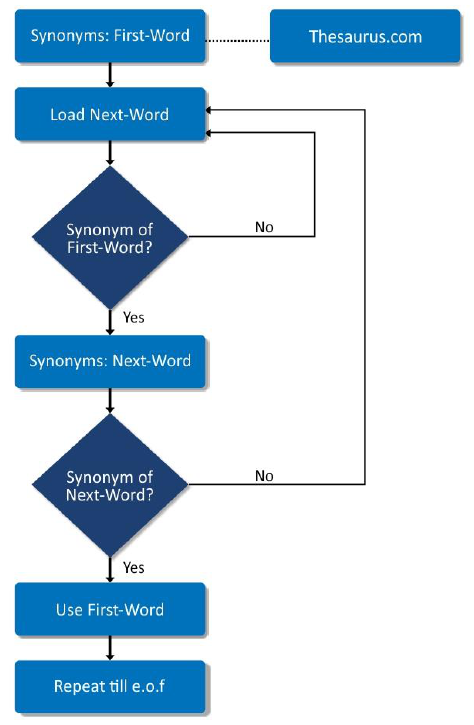
Figure 4. The cross() function for synonym